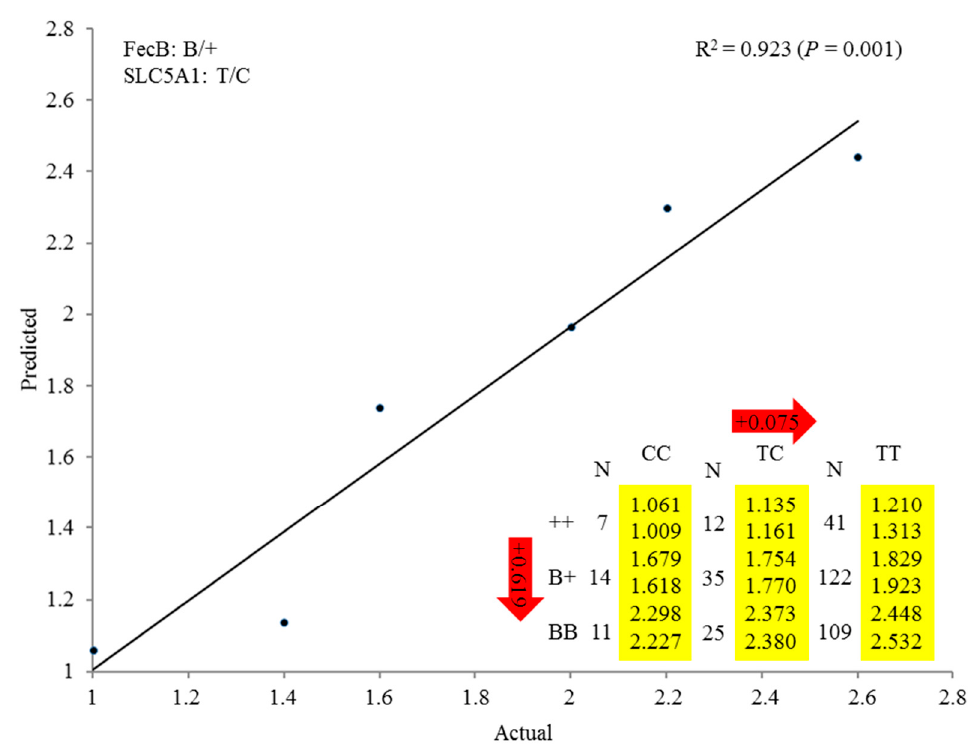
Figure 2. Genetic networks associated with average litter size in Small-Tail Han sheep. The numbers in arrows represent the substitution effects of one genotype or allele on another. Predicted (top) and actual (bottom) performance values for combined genotype(s).